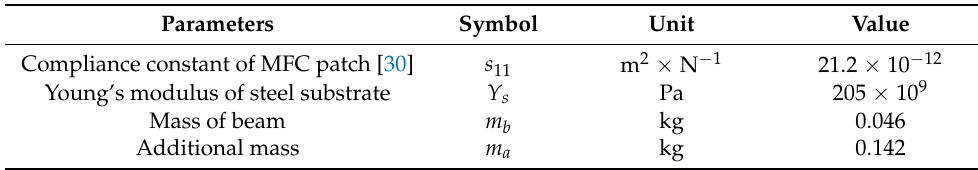
Table 2. Material properties of the composite